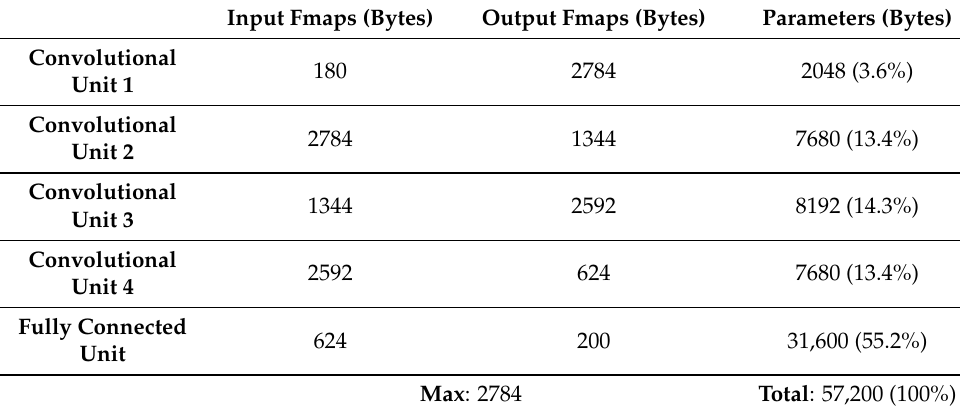
Table 4. ECG-ID-BNet memory usage